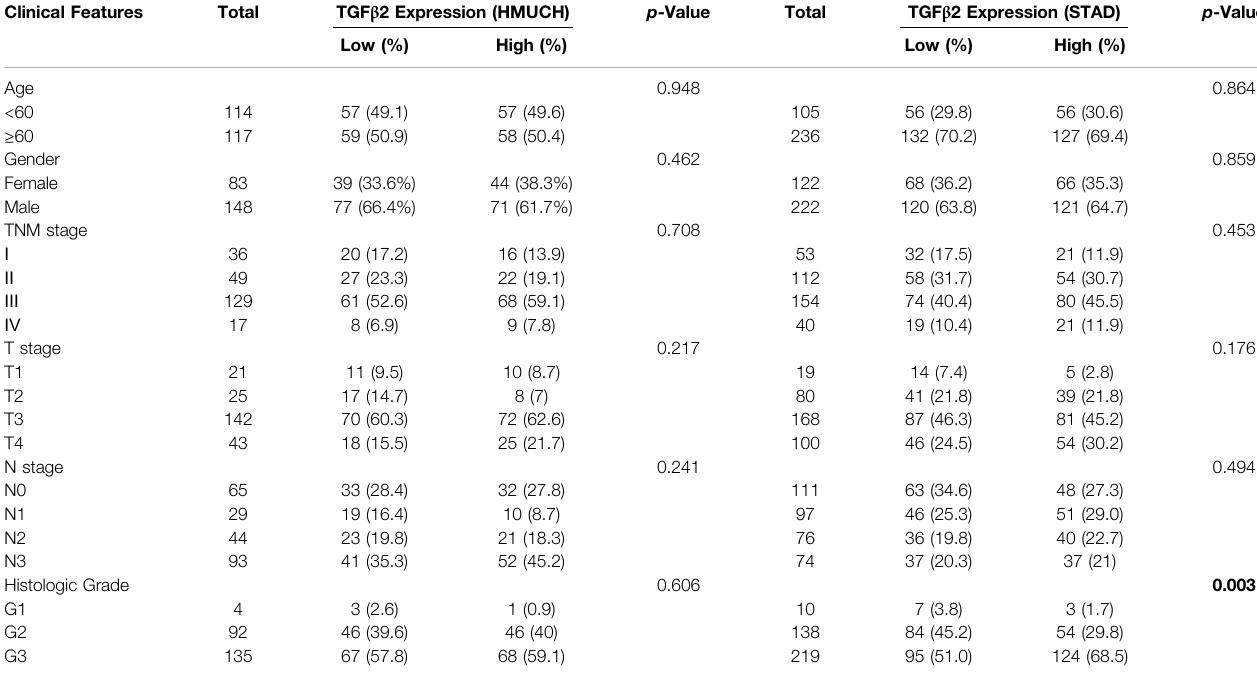
TABLE 1 | The relationship between TGF β 2 expression and clinicopathological factors in HMUCH (GSE184336) and TCGA-STAD database. Clinical